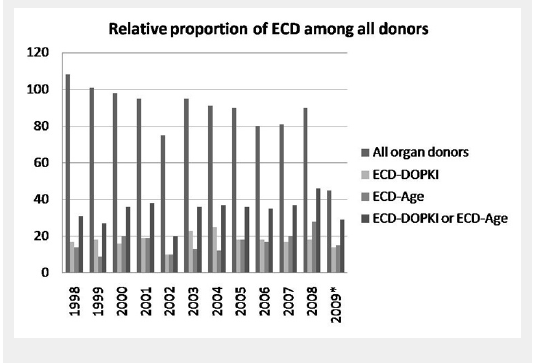
Relative proportion of ECD among all organ donors. Number of ECD (ECD-DOPKI, ECD-Age and ECD-DOPKI or ECD- Age) and number of all donors in Switzerland from 1998-2009. The 2009 data were available until July only.